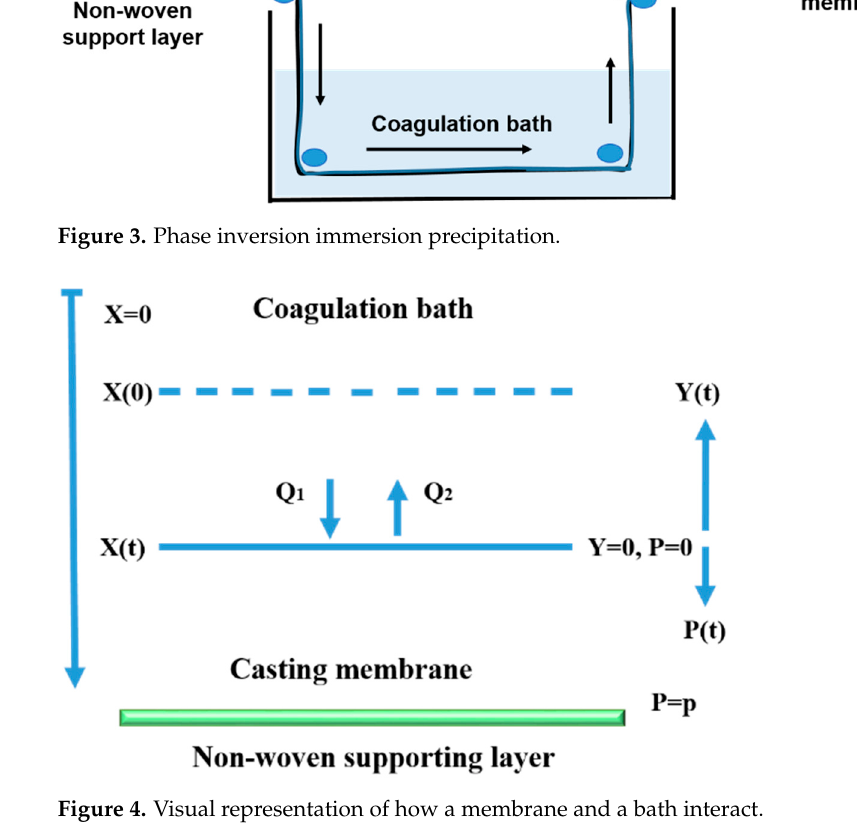
Figure 4. Visual representation of how a membrane and a bath interact.